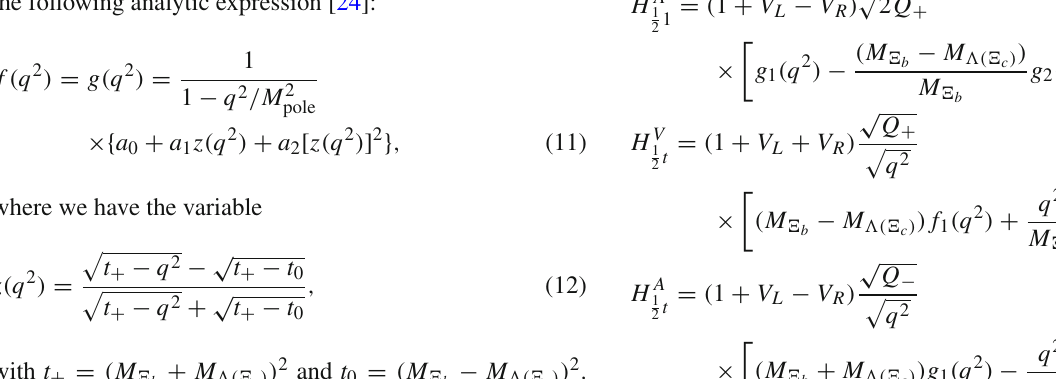
Table 1 Form factors for the weak (cid:2) b → (cid:3) and (cid:2) b → (cid:2) c